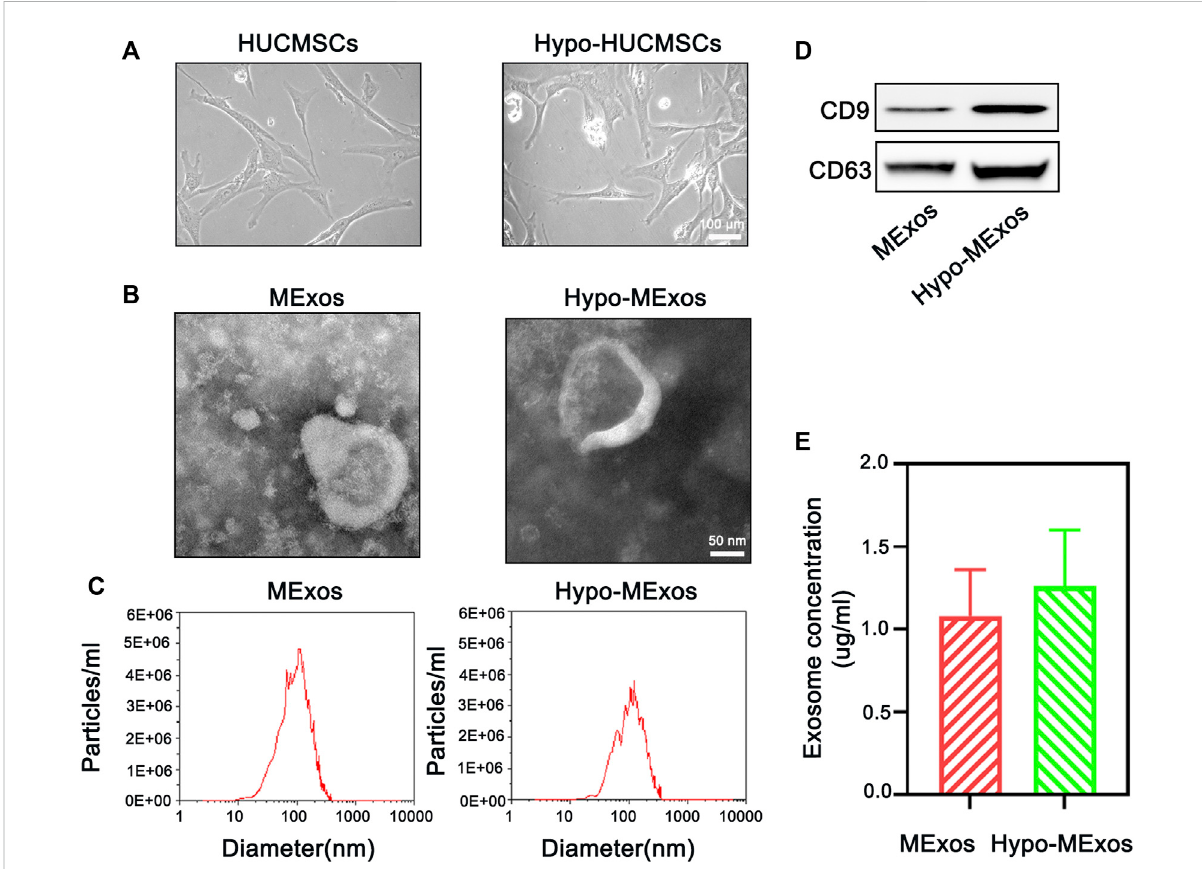
FIGURE 1 CharacterizationofHUCMSC-derivedexosomesundernormoxicconditions(MExos)andhypoxicconditions(Hypo-MExos). (A) Morphologyof HUCMSCs and Hypo-HUCMSCs observed under a phase-contrast microscope. (B) TEM images of MExos and Hypo-MExos. (C) Particle size distributions of exosomes detected by NTA. (D) Western blot illustrating the characteristic surface markers of exosomes, CD9 and CD63. (E) Exosome concentration was determined by BCA quanti fi